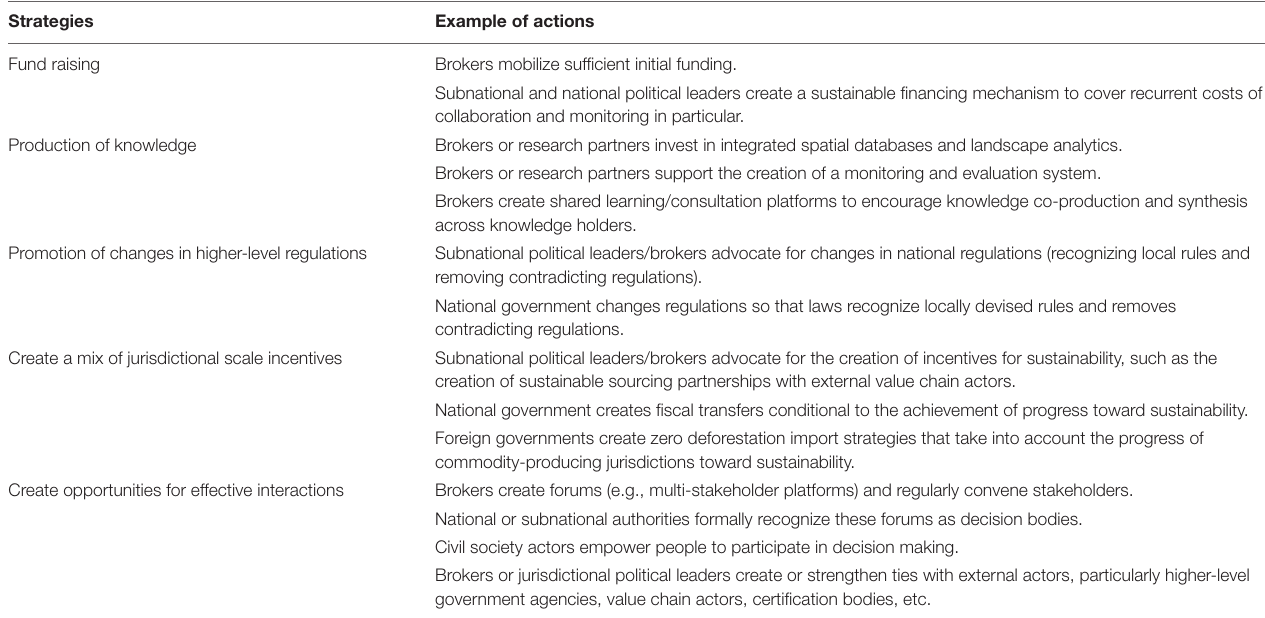
TABLE 3 | Key intervention strategies for a jurisdictional